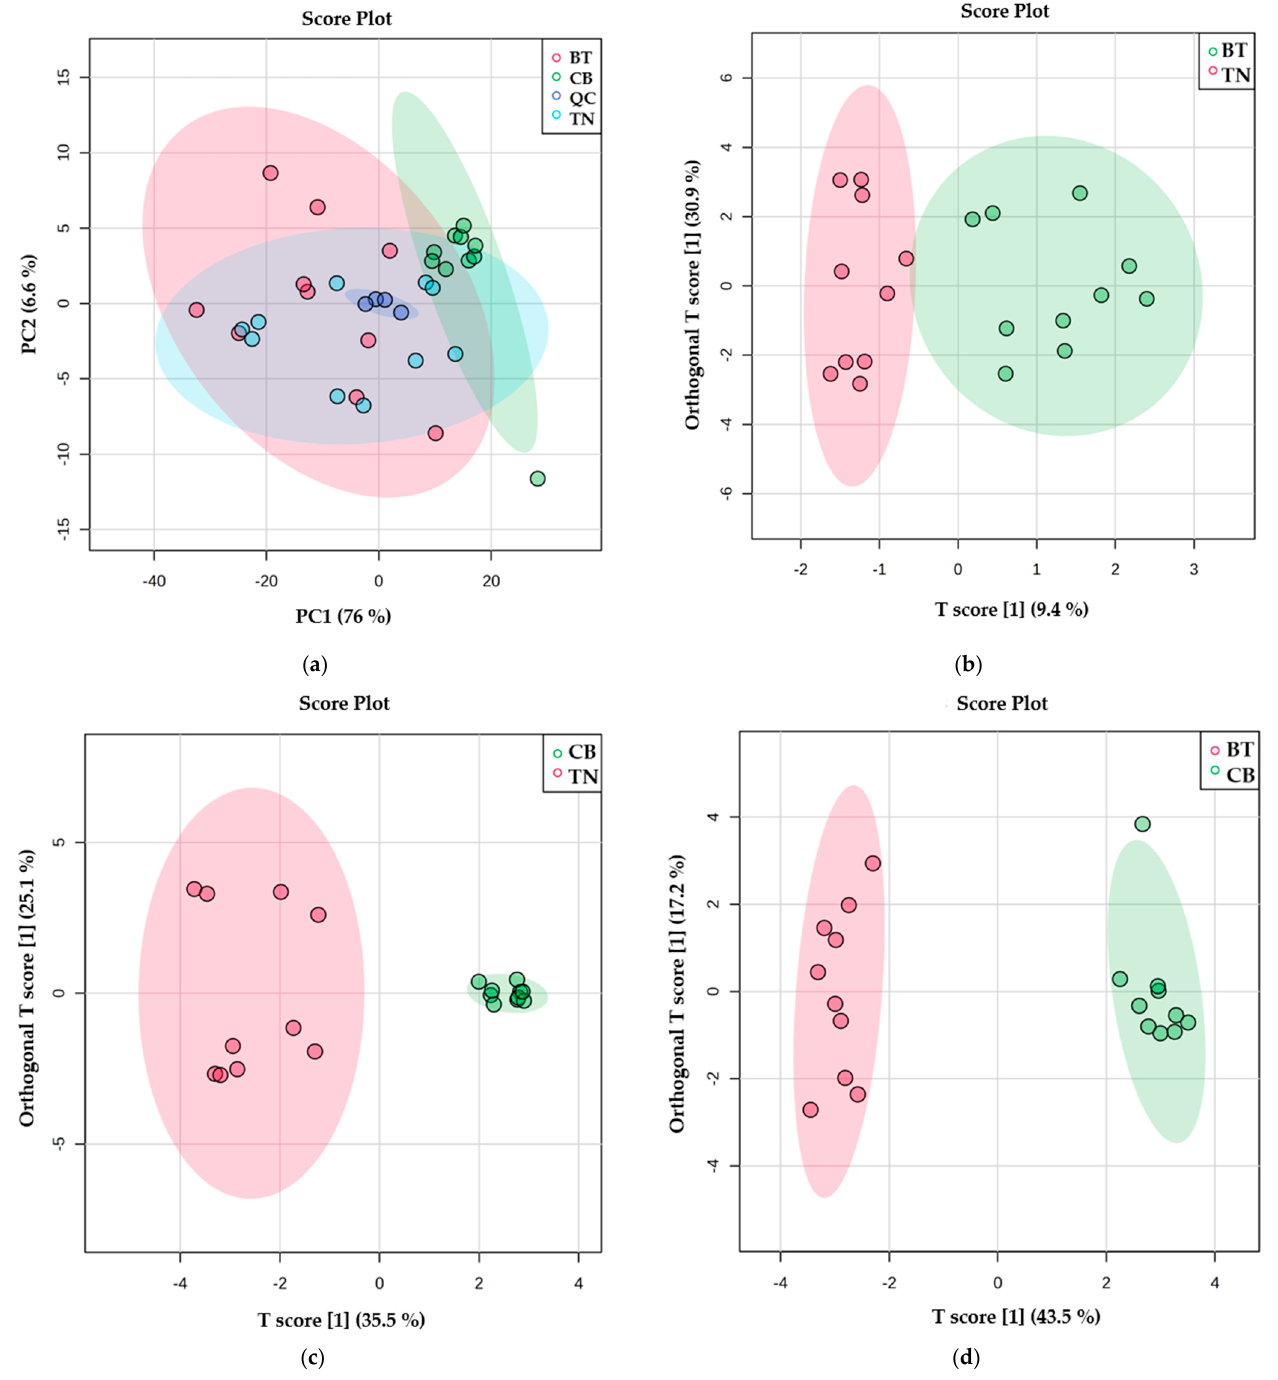
Figure 2. PCA ( a ) score plot of PC1 and PC2, and pairs of OPLS-DA ( b – d ) score plots of orthogonal T score [1] versus T score [1] produced from beef metabolites. ( a ) Overall, R 2 X = 0.563, Q 2 X = 0.288; ( b ) TN vs BT, R 2 X = 0.705, R 2 Y = 0.839, Q 2 Y = 0.152; ( c ) TN vs CB, R 2 X = 0.606, R 2 Y = 0.938, Q 2 Y = 0.866; ( d ) BT vs CB, R 2 X = 0.693, R 2 Y = 0.987, Q 2 Y = 0.941. Abbreviations are as follows: Thai native beef (TN), Brahman × Thai native beef (BT), Charolais × Brahman beef (CB), and Quality Control (QC).